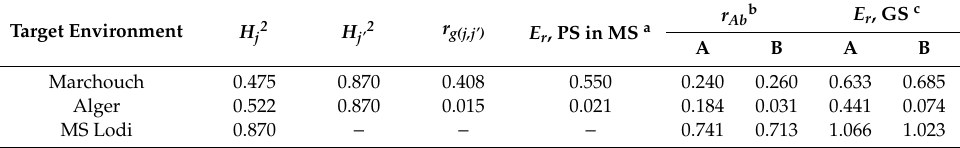
Table 2. Predicted e ffi ciency ( E r ) relative to direct phenotypic selection (PS) for pea grain yield in the target environment of (i) indirect PS in a managed drought stress (MS) environment (Lodi, Italy) for two agricultural sites (Marchouch, Morocco; Alger, Algeria); (ii) genomic selection (GS) using a model trained on line yield data from the target environment (A) or on data averaged across the MS environment and Marchouch (B), for three environments.